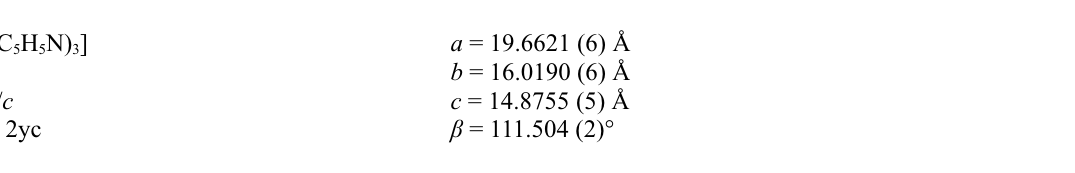
Packing diagram viewed down the b axis, catena-Poly[[tripyridinenickel(II)]- µ -5-bromoisophthalato] Crystal